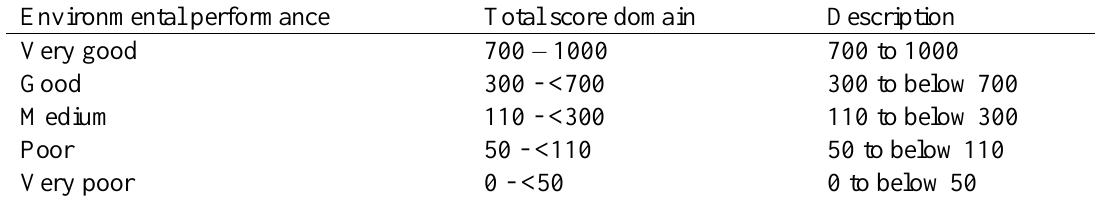
Table 8. Environmental performance in medical